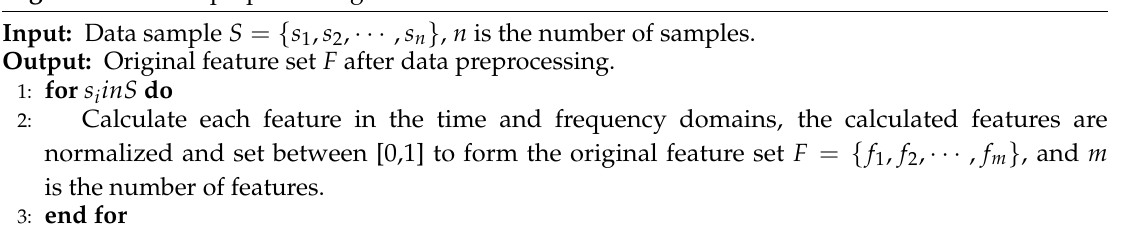
Algorithm 4 Data